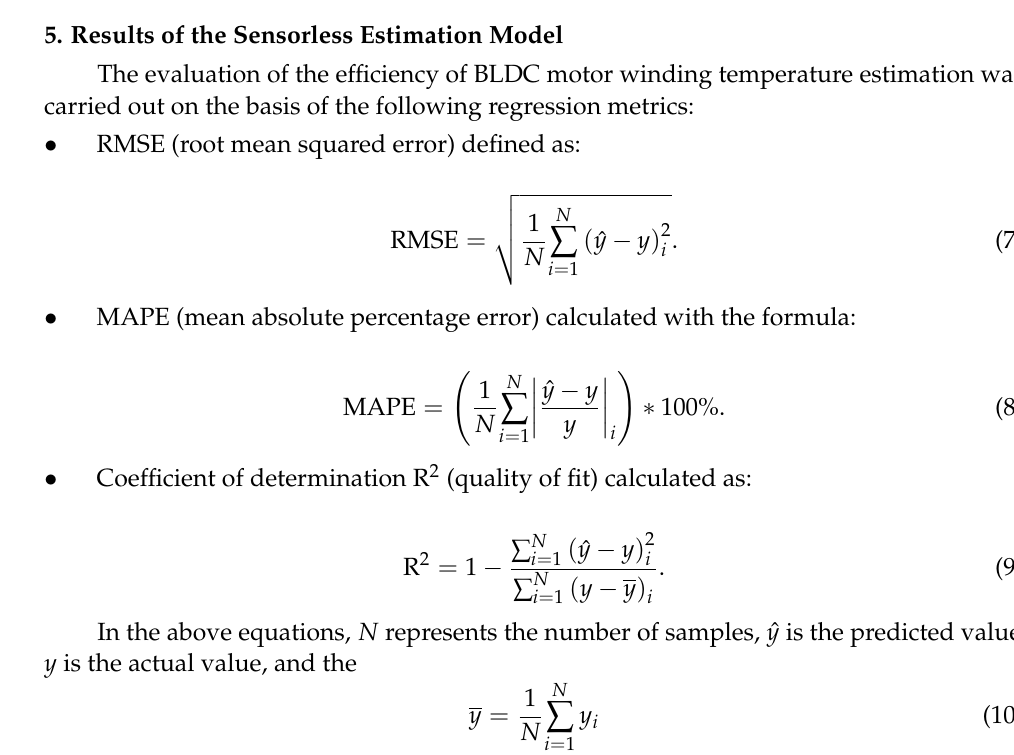
Figure 6. Time-series five-fold